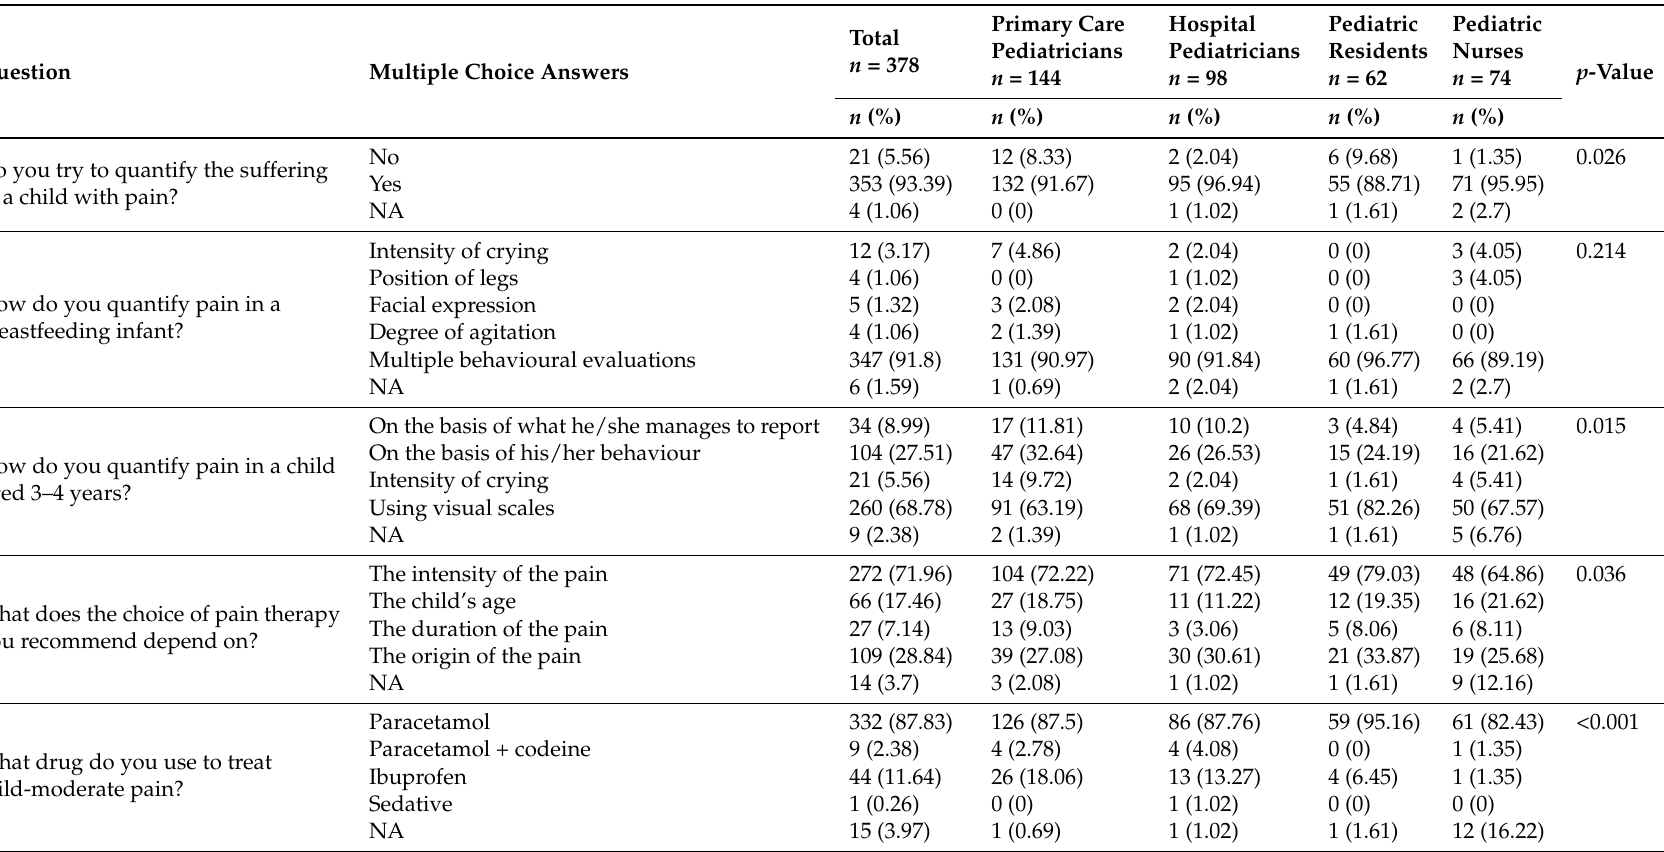
Table 3. Pain management by healthcare